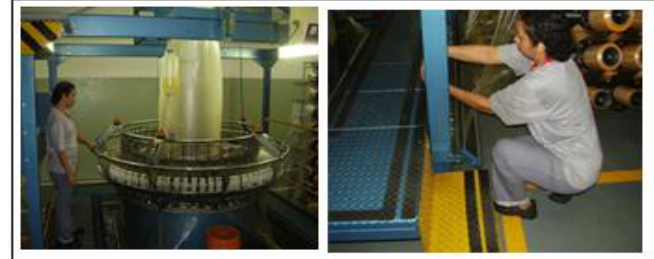
Figura 1: Mostra a colaboradora iniciando suas atividades. Os princípios mais importantes da biomecânica para a Ergonomia. No caso das colaboradoras da Amapoly Indústria e Comercio LTDA ressalta que as articulações devem ocupar uma posição neutra; conservar pesos e flexões próximos ao corpo; evitar curvar-se para frente; evitar inclinar a cabeça; evitar torções de tronco e movimentos bruscos que produzem picos de tensão; alternar posturas e movimentos; restringir a duração do esforço muscular contínuo; prevenir a exaustão muscular e opção por pausas curtas e frequentes por se tratar de uma atividade onde as colaboradoras trabalham em pé durante 8 horas diárias exercendo atividades conforme a Figura 2.